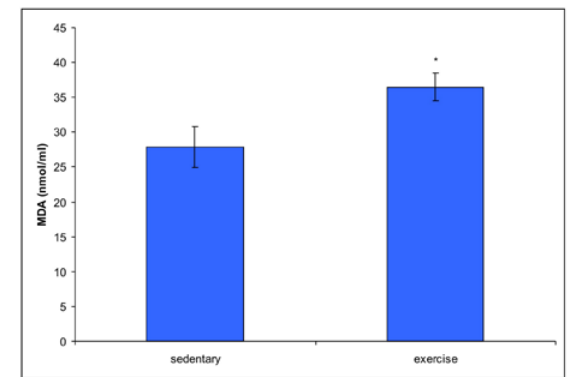
Figure 4. The effects of five minutes treadmill exercise on malo- ndyaldehide (MDA) levels from the rat serum. The values are mean ± SEM (n=7 animals per group). *p=0.03 vs. sedentary-control group.